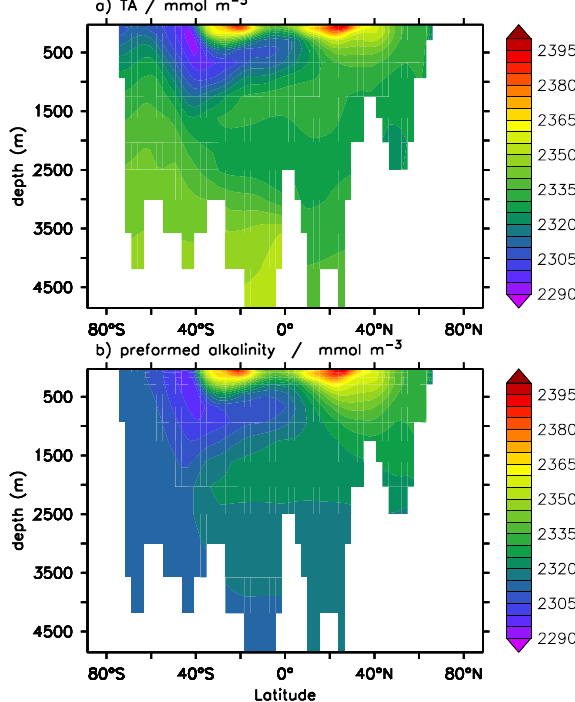
Figure 3. Horizontal sections of alkalinity ( a , GLODAP) and salin- ity ( b , WOA) along 30 ◦ W in the Atlantic Ocean. For the scaling of the isolines see caption of Fig. 2. Alkalinity patterns, particularly in the upper 2000m, largely follow patters of salinity indicating a pre- dominantly conservative behaviour of alkalinity in the interior of the Atlantic Ocean. The r 2 of (a) over (b) is 0.692.